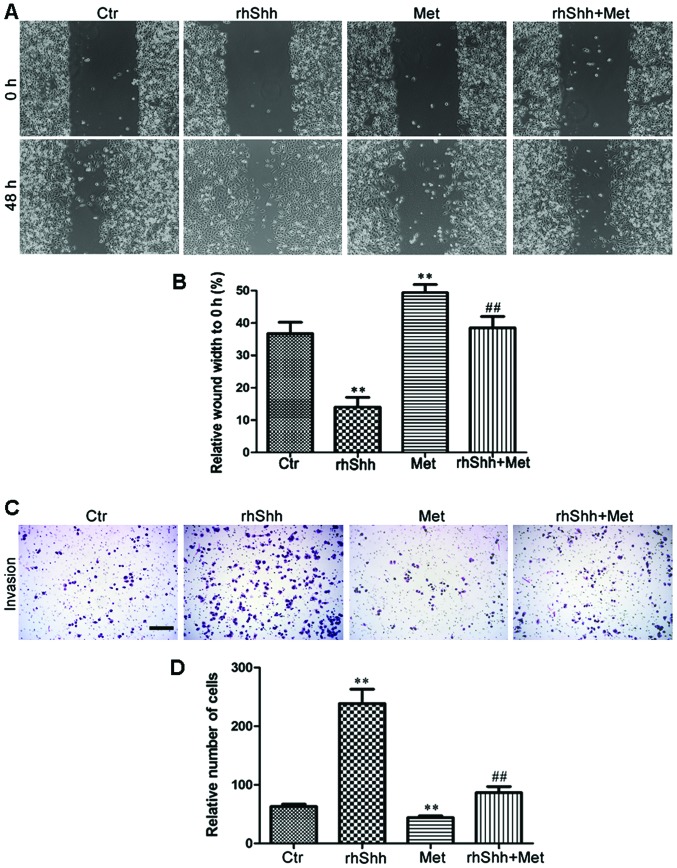
Metformin suppresses the rhShh-induced cell migration and invasion. (A) Representative images of the wounds at 0 and 48 h in the presence of recombinant human Sonic hedgehog (rhShh), metformin or their combination. (B) Histogram illustrates the relative wound width at 0 and 48 h. The migration distance of each cell was measured using Adobe Photoshop. (C) Matrigel invasion assay. Cells were seeded into Matrigel-coated invasion chambers and were treated with rhShh, metformin or their combination for 24 h. Representative images of stained and invaded cells are shown. Magnification, ×10. (D) The number of invaded cells was quantified by counting the cells from 5 random fields. All data represent the means ± SD of 3 separate experiments (**P<0.01 vs. the Ctr group, ##P<0.01 vs.the rhShh group).